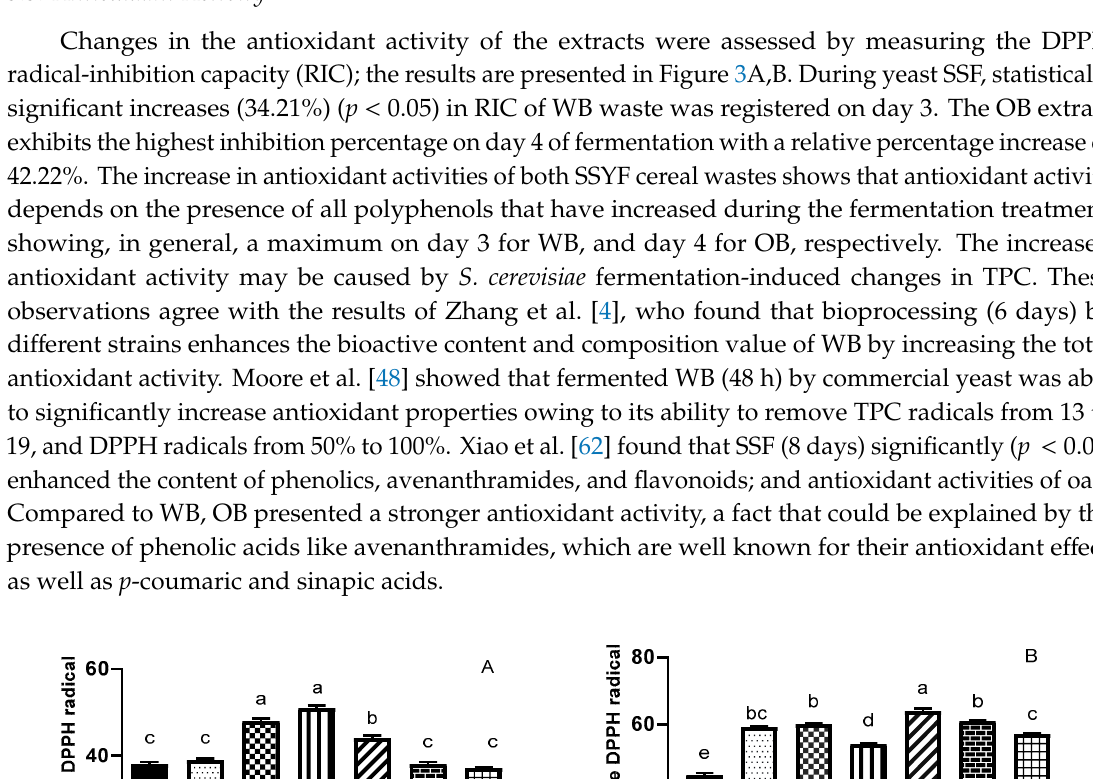
Figure 2. Total phenolic content (Folin–Ciocalteu method) ( A illustrating WB; B illustrating OB) of the extracts (control and fermented (6 days)). Total phenolic content of the extracts is expressed as gallic acid equivalents (GAE) in mg/g sample of waste. Values are expressed as mean values ± SD, µg/g, n = 3, and are followed by different letters (a–f), indicating significant differences ( p < 0.05) between days of fermentation (One-way ANOVA - Multiple comparison test - Tukey multiple range test ( p = 0.05); GraphPad Prism Version 8.0.1, Graph Pad Software, Inc., San Diego, CA, USA).